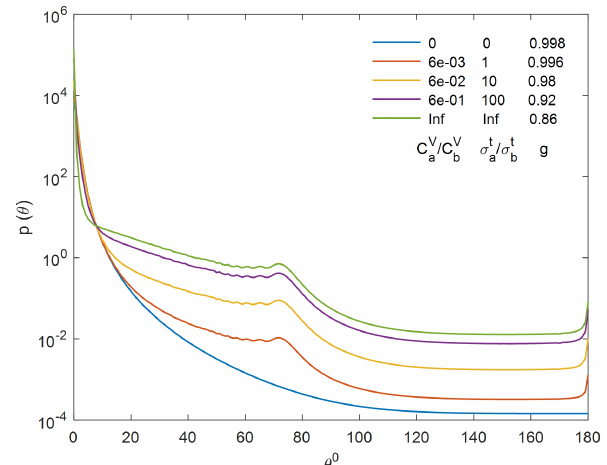
Figure 2. Phase functions of the mixture of air bubbles and brine in- clusions at − 2 ◦ C with different fraction ratio C V a /C V transport scattering coefficients σ t a /σ t also shown. The effective sizes are R a = 42 . 55µm, R b =